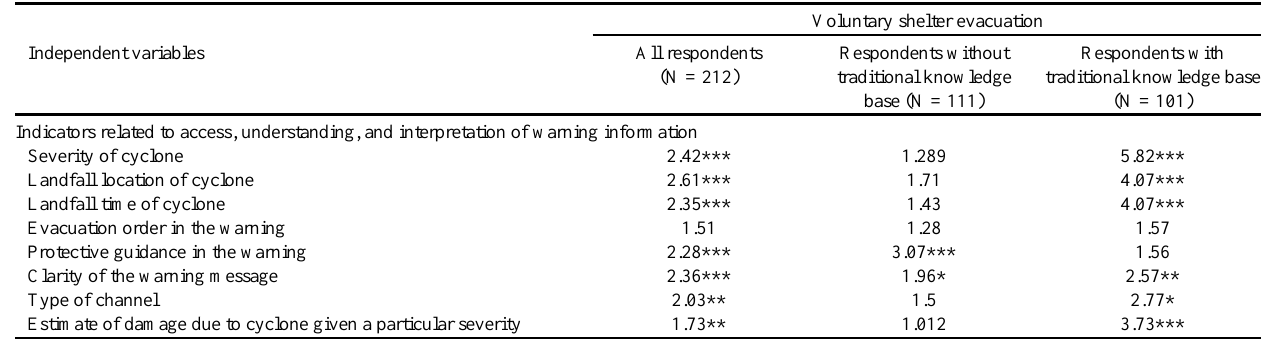
Table 4 . Bivariate logistic regression of evacuation predictors on evacuation among all respondents and separately by presence or absence of traditional knowledge base.